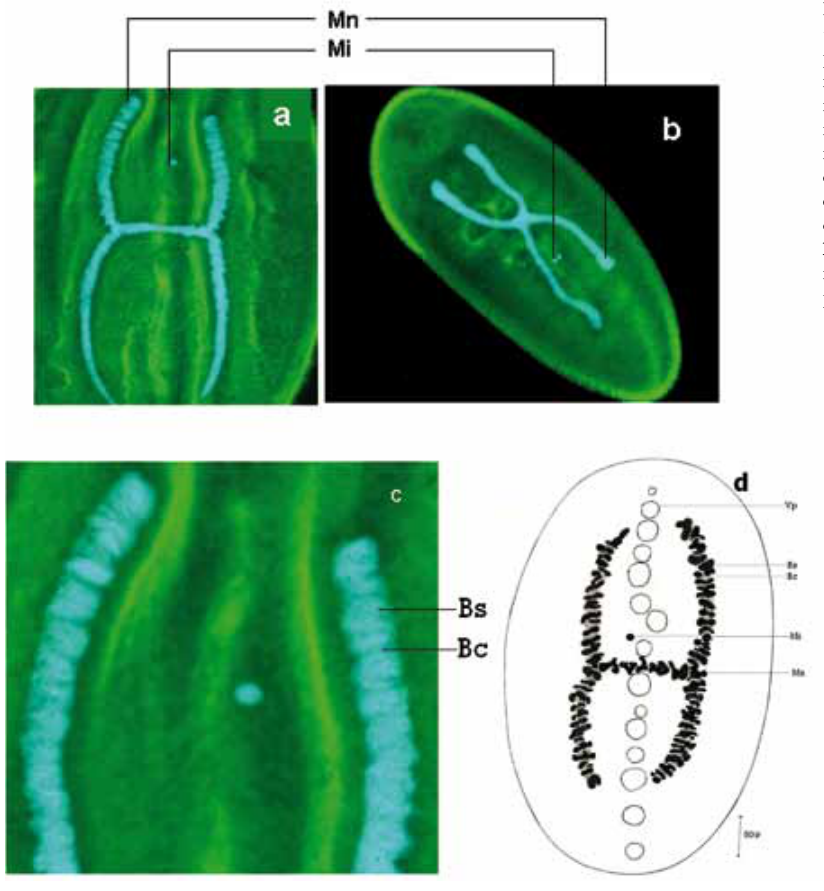
Fig. 4. – Appareil nucléaire d’ Almophrya mediovacuolata . Superposition d’images prises en microscopie à fluorescence après marquage du noyau par le DAPI. a et d : macronoyau en “H” à aspect empilé ; b : macronoyau en forme de “X”; c : partie du macronoyau en “H” montrant les distributions distinctes d’une alternance de bandes